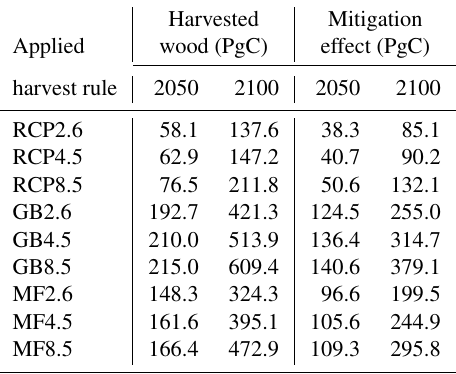
Table 2. Net mitigation potentials of GB (growth-based), MF (man- aged forest), and RCP (Representative Concentration Pathway) har- vest at the middle and end of the 21st